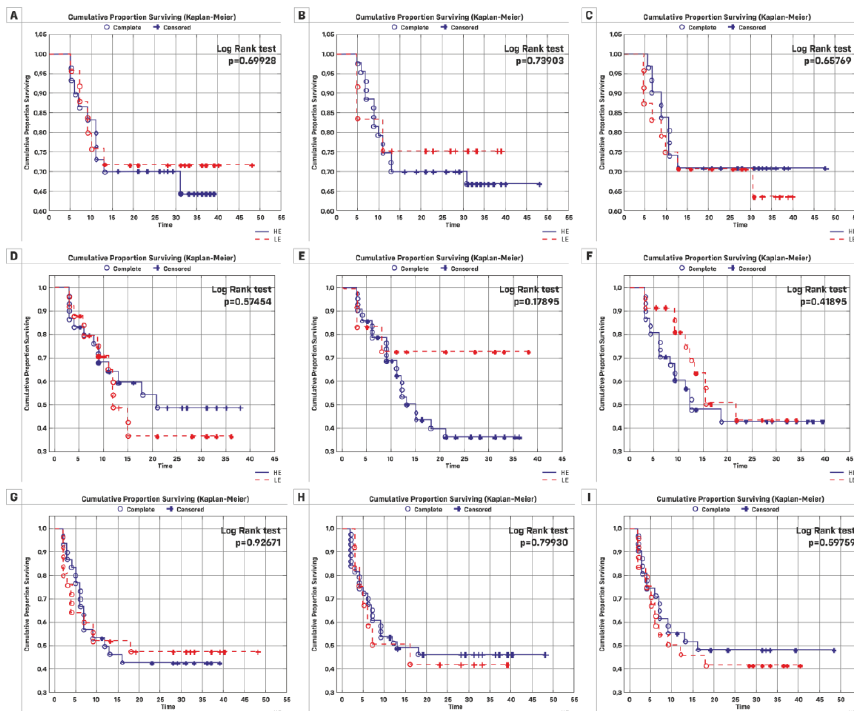
Figure 2. Kaplan–Meier plots for patients’ group divided into low expression (LE) and high expression (HE): Cancer-specific survival ( A ) miR-145-5p, ( B ) miR-21-5p, and ( C ) miR-182-5p; recurrence free-survival ( D ) miR-145-5p, ( E ) miR-21-5p, and ( F ) miR-182-5p; and progression-free survival ( G ) miR-145-5p, ( H ) miR-21-5p, and ( I ) mir-182-5p.